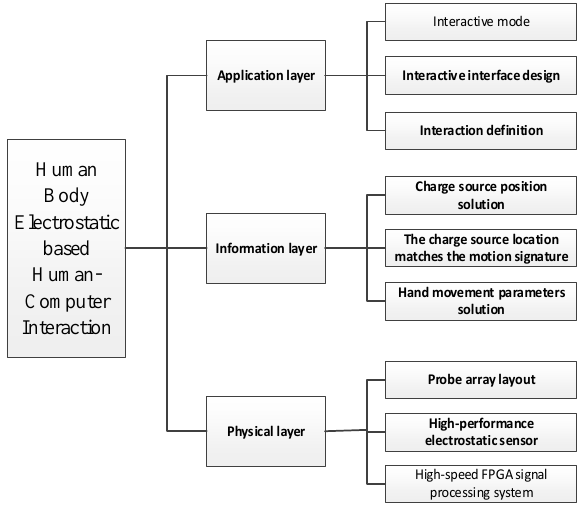
Figure 7. Architecture diagram depicting the overall scheme.